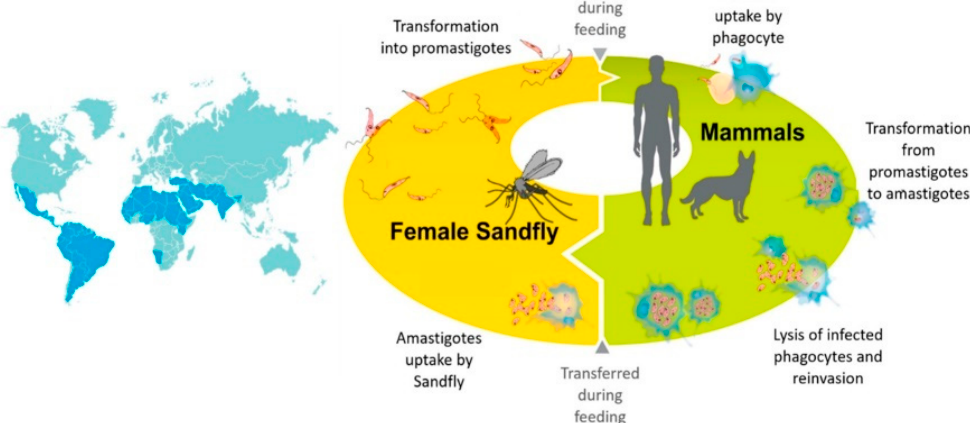
Figure 7. Geographical distribution of leishmaniasis in the world ( left panel ). Life cycle of Leishmania in sandfly and mammalian host ( right panel ). The two main evolutionary forms during their life cycle: the promastigote (in the invertebrate host) and the amastigote (present in the vertebrate host) are shown. Globally, more than 20 Leishmania species exist, transmitted by over 90 phlebotomine sandfly species (Reprinted from ref. [68]. Copyright 2021 by the authors. Licensee MDPI, Basel, Switzerland).